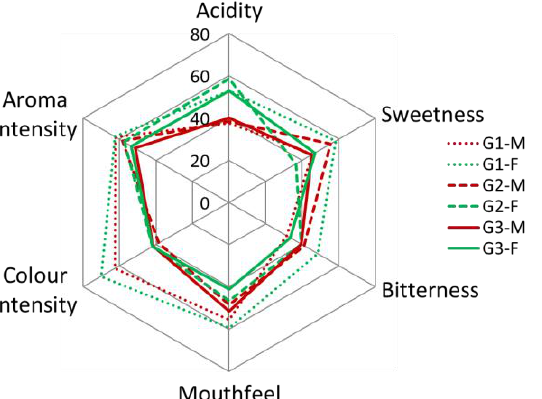
Figure 4. Gender comparisons of sensory perception of beverages from G1 (dotted lines), G2 (dashed lines) and G3 (continuous line); green lines—women’s perception (F), red lines—men’s perception (M).